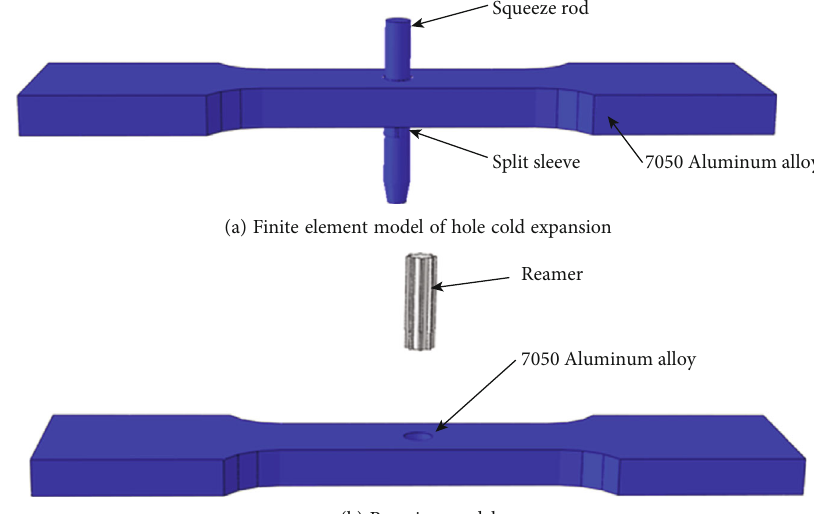
Figure 4: Finite element model.